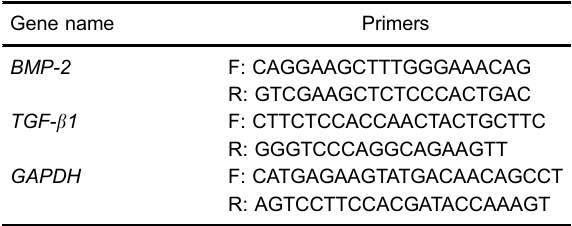
BMP-2 : bone morphogenetic protein-2; TGF- b 1 : transforming